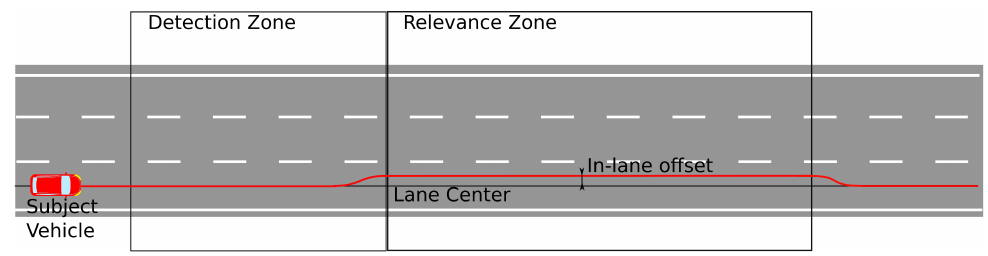
Figure 1. In-lane off-set recommendation scenario description.